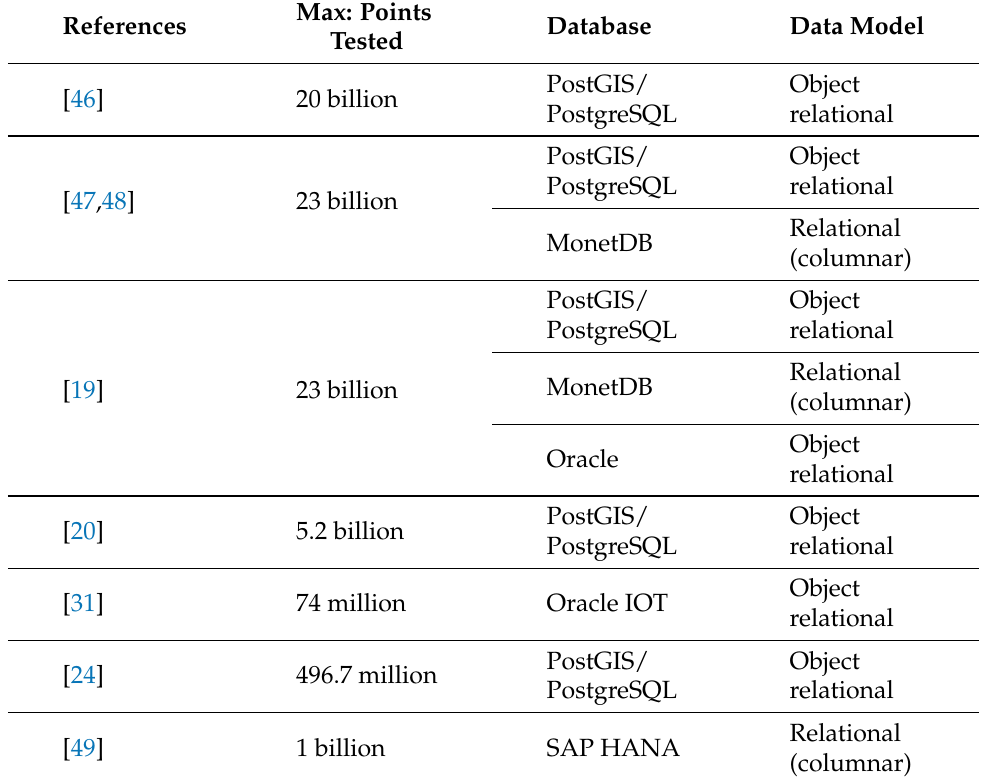
Table 2. shared-memory architecture-based PCDM